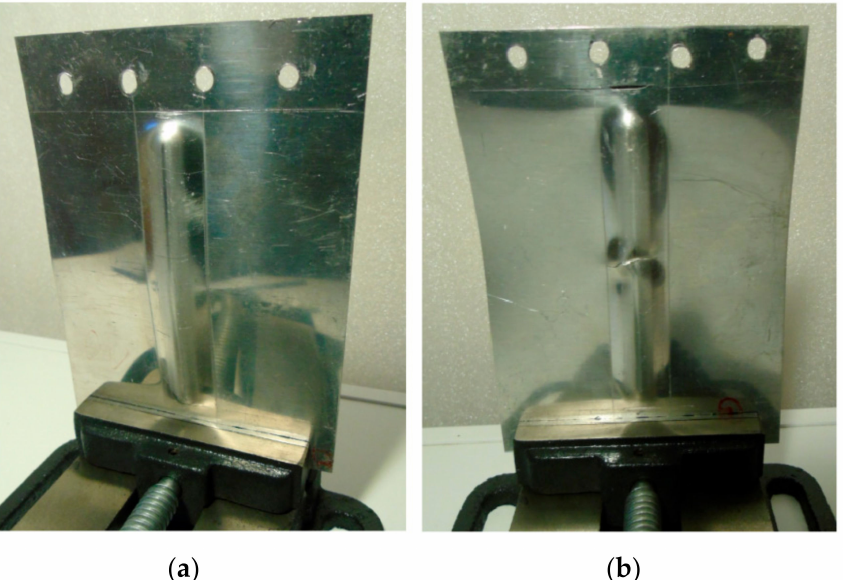
Figure 12. Buckling mode of 0.8-mm-thick EN AW-7075-T6 Alclad panel: ( a ) Mode A—the panels buckled halfway up the panel width towards the rib, without any appreciable loss of rib stability; ( b ) Mode B—the rib first lost stability at half height, which was associated with breakage of the rib, and then the panel was deflected in the opposite direction to the position of the rib.